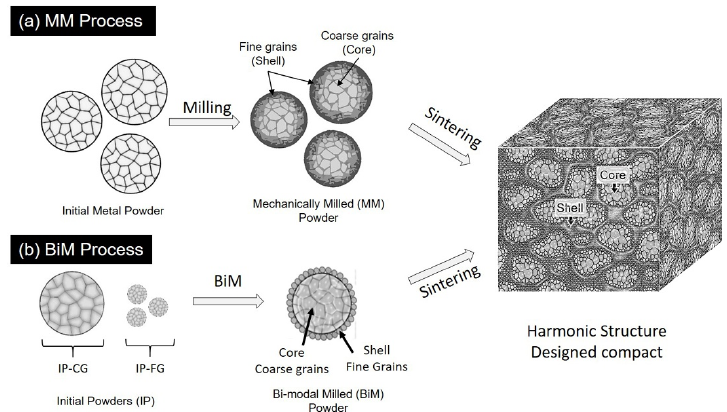
Figure 3. Fabrication processes of the harmonic structure materials; ( a ) Mechanical Milling (MM) and ( b ) Bimodal Milling (BiM) process. ( b ) Bimodal Milling (BiM)